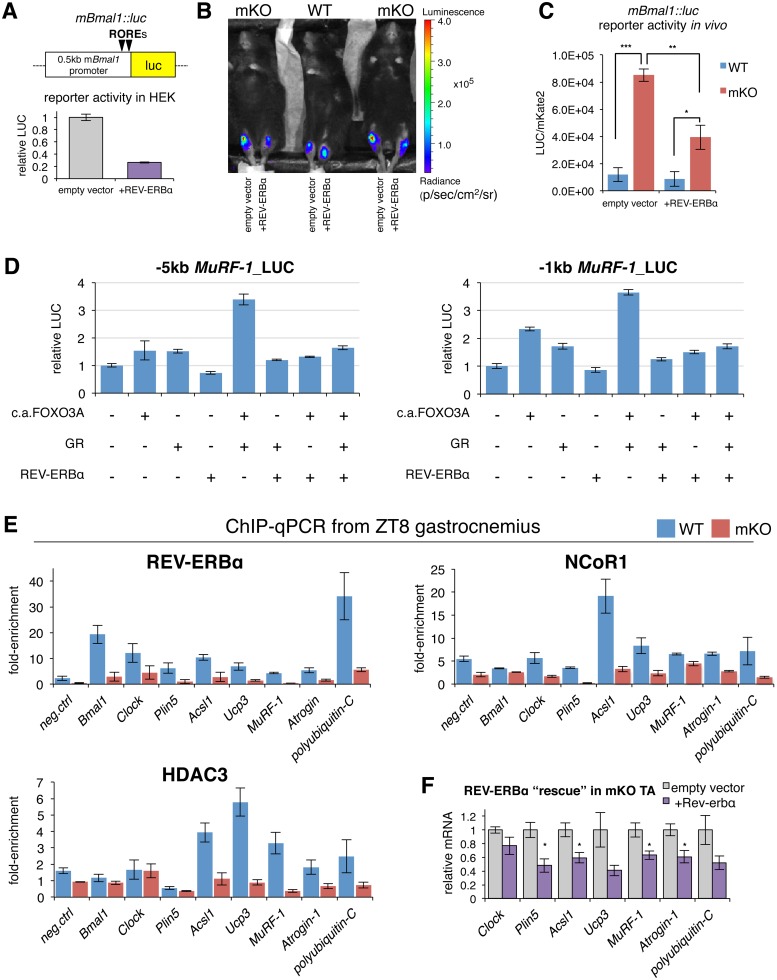
REV-ERBα controls muscle lipid and protein metabolism by directly repressing key regulators.(A) Cotransfection of HEK-293T cells with empty control vector or mouse REV-ERBα expression plasmid, along with REV-ERB sensor (mBmal1::luc), containing 2 ROREs from the proximal promoter of Bmal1 linked to LUC. Data from 2 independent experiments are expressed as mean fold-change normalized to the empty vector (n = 6; ±SEM). (B) In vivo imaging of LUC activity in WT and mKO mouse TA muscles following electric pulse–mediated gene transfer of mBmal1::luc cotransfected either with empty vector or REV-ERBα expression plasmid. Imaging analysis was performed 3 d after gene transfer at ZT10 as described in Materials and methods. Pseudocolors overlaid on the image indicate the luminescence intensity from mBmal1::luc reporter gene activity as indicated by the scale bar radiance (photons/second/cm2/steradian). (C) Quantification of LUC activity in TA muscles normalized to mKate2, an exogenous spike-in control plasmid (mean ± SEM; n = 3 mice; *p < 0.05, **p < 0.01, ***p < 0.001, Student’s t test). (D) Cotransfection of HEK-293T cells with empty control vector, mouse REV-ERBα expression plasmid, mouse GR expression plasmid, or c.a.FOXO3A expression plasmid, along with GR:FOXO sensor containing −5 kb or −1 kb promoter sequence from mouse MuRF-1 linked to LUC. Data are expressed as mean fold-change normalized to the empty vector (n = 2–3; ±SEM). (E) In vivo REV-ERBα, NCoR1, and HDAC3 occupancy at target sites in control and mKO gastrocnemius at ZT8 (mean fold-enrichment over IgG ± SEM; n = 4 independent biological replicates from 4 independent ChIP-qPCR experiments; Foxl2 promoter used as negative control). (F) Gene expression (RT-qPCR) of mKO TA muscles at ZT10 following electric pulse-mediated gene transfer of REV-ERBα expression plasmids or empty vector. Data normalized to 36B4 expression and expressed as fold-change relative to contralateral muscle containing empty vector (mean ± SEM, n = 4 mice, *p < 0.05, Student’s t test). Underlying data can be found in supporting file S1 Data. BMAL1, brain and muscle ARTN-like protein 1; c.a.FOXO3A, constitutively active forkhead box O3; ChIP-qPCR, chromatin immunoprecipitation–quantitative real-time PCR; CLOCK, circadian locomotor output cycles kaput; GR, glucocorticoid receptor; HDAC3, histone deacetylase 3; HEK-293T, human embryonic kidney 293T; IgG, immunoglobulin G; LUC, luciferase; mKO, myocyte-specific loss of BMAL1; NCor1, nuclear receptor corepressor 1; PDH, pyruvate dehydrogenase; ROR, RAR-related orphan receptor; RORE, ROR response element; RT-qPCR, quantitative reverse transcription PCR; TA, tibialis anterior; ZT, Zeitgeber time.